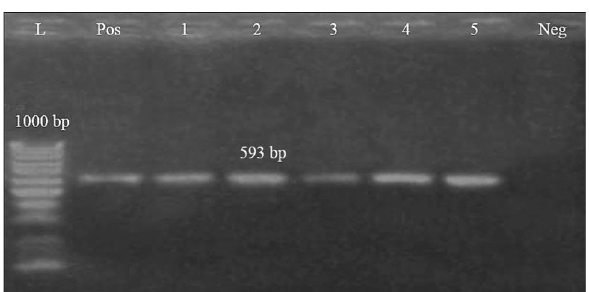
Figure 9. Electrophoretic pattern of primers targeting bla CTM gene. Lane L: 100 bp molecular weight ladder (Fermentas, Thermo Scientific, Germany); lane Pos: the positive control (Reference strain from Animal Health Research Institute in Dokki, Cairo, Egypt), and lane Neg: the negative control (template without DNA). Lanes 1–5: the specific DNA product (593 bp) amplified from representative strains of P. aeruginosa